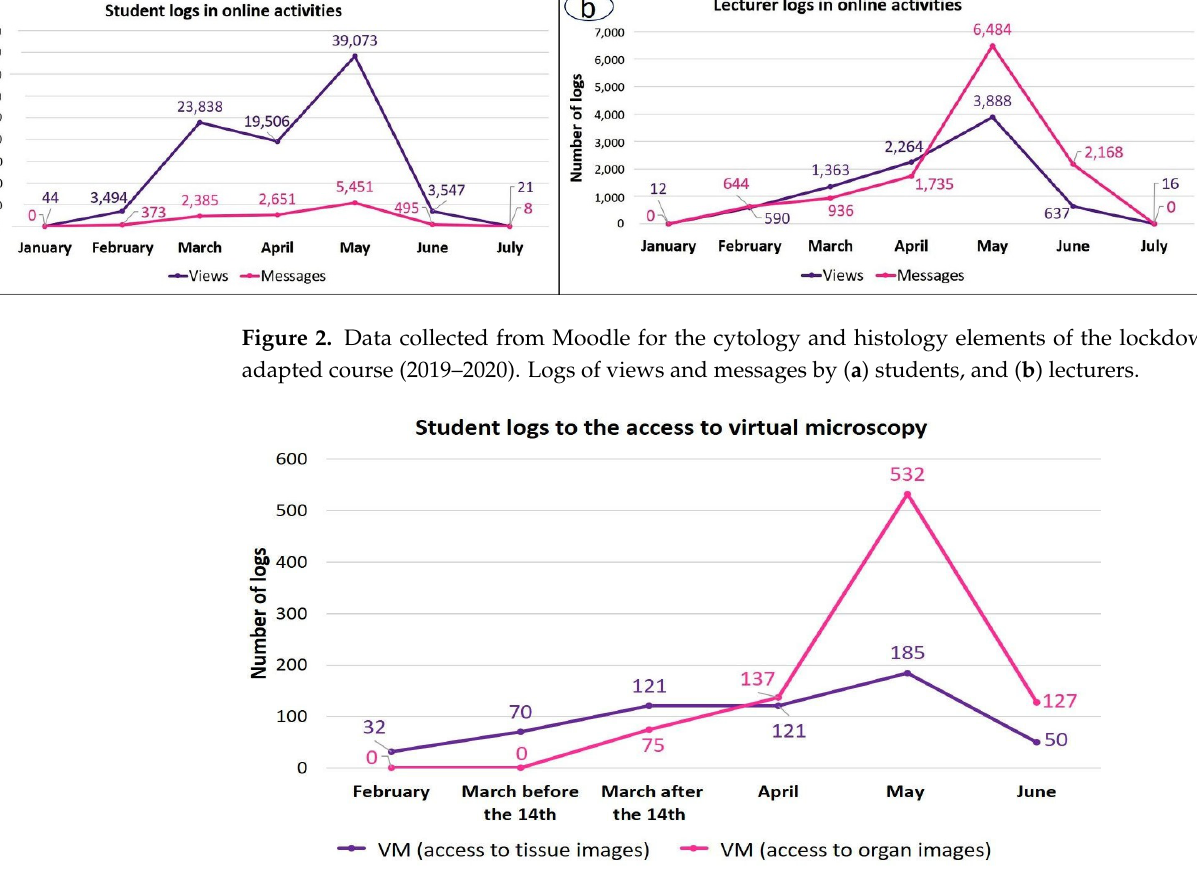
Figure 3. Data collected from Moodle throughout the lockdown-adapted course (2019–2020). Logs of students’ access to virtual microscopy (VM).